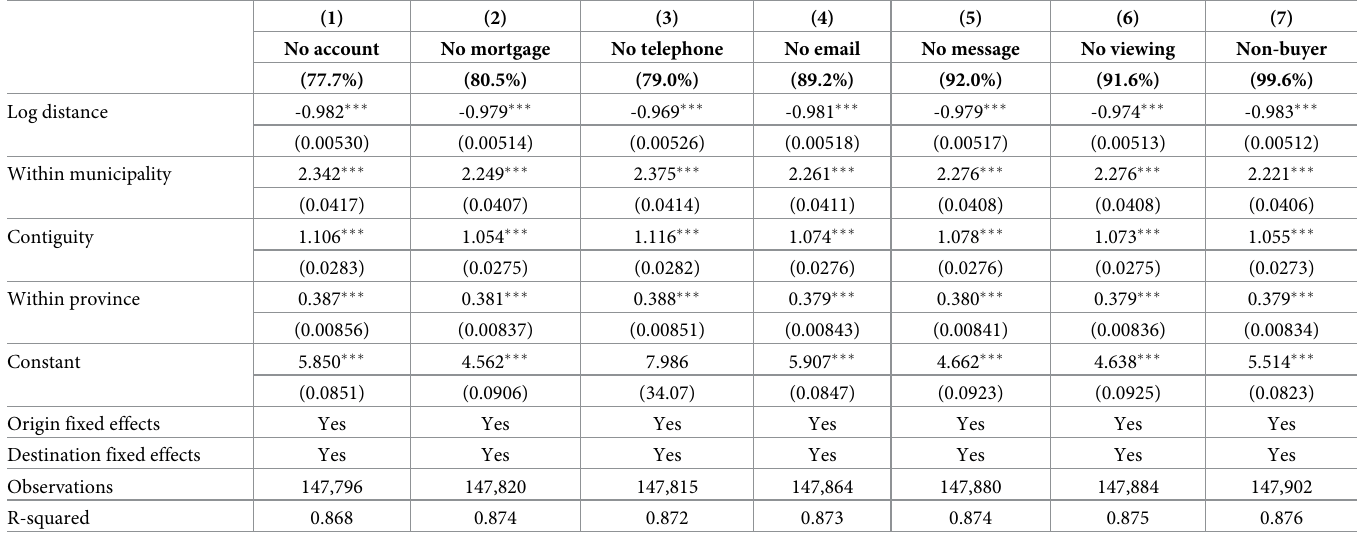
Table 4. Ordinary least squares estimates for recreational